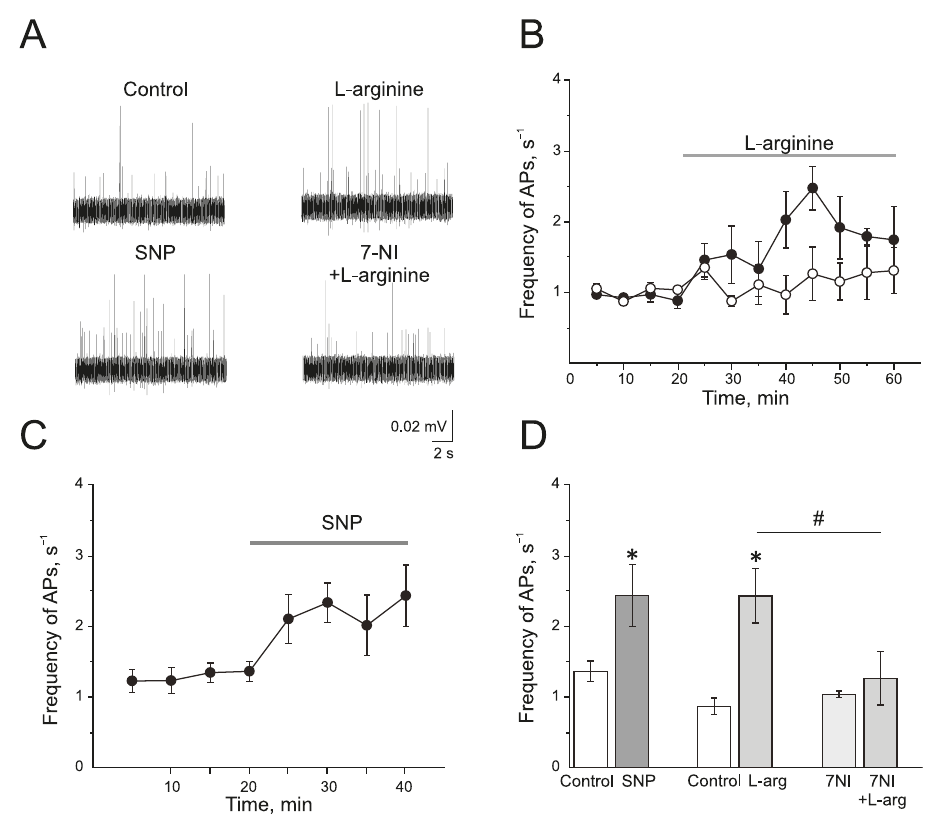
Figure 2. Endogenous and exogenous nitric oxide (NO) increases the electrical activity of rat trigem- inal afferents. ( A ) Sample traces of AP in the trigeminal nerve of a rat in the control and after the application of L-arginine (300 µ M), NO donor SNP (200 µ M), and L-arginine in the presence of nNOS inhibitor, 7-nitroindazole (7NI, 1 mM); ( B ) The time-course of AP frequency after the application of L-arginine (black circles) and in the presence of 7NI (white circles); ( C ) The time-course of frequency of AP after the application of SNP; ( D ) Histogram showing the maximum frequency of AP per 5 min after the application of L-arginine, SNP, 7NI and 7NI + L-arginine. Mean ± SEM. * p < 0.05